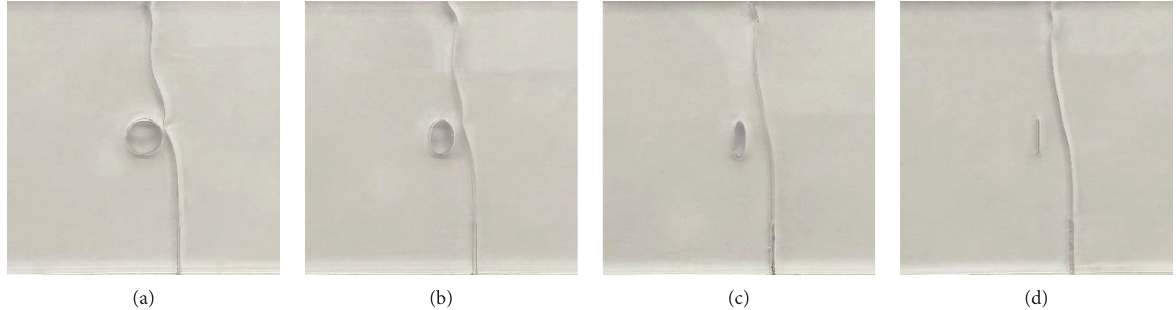
Figure 4: Fracture morphology of specimens. (a) S